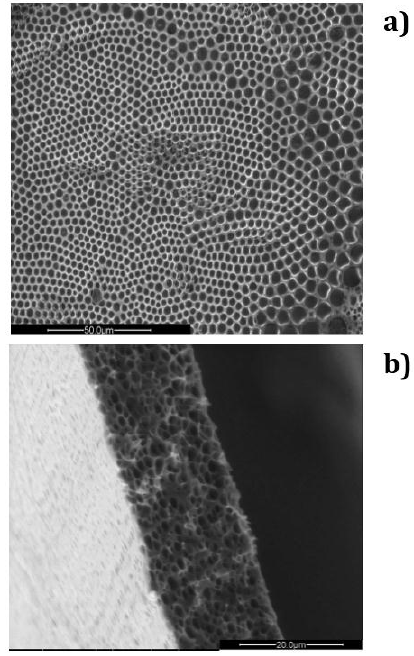
Figure 2. SEM micrographs related to a honeycomb membrane prepared from a PSU/DCM/2-propanol solution: ( a ) top surface and ( b ) cross-section of the membrane.